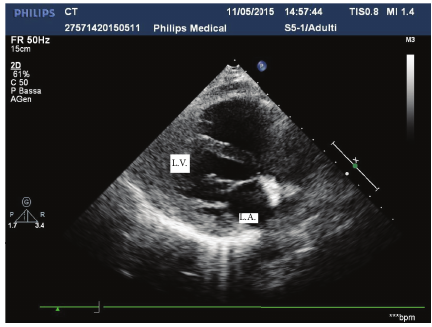
Figure 1: Long axis view. L.A.: left atrium; L.V.: left ventricle.